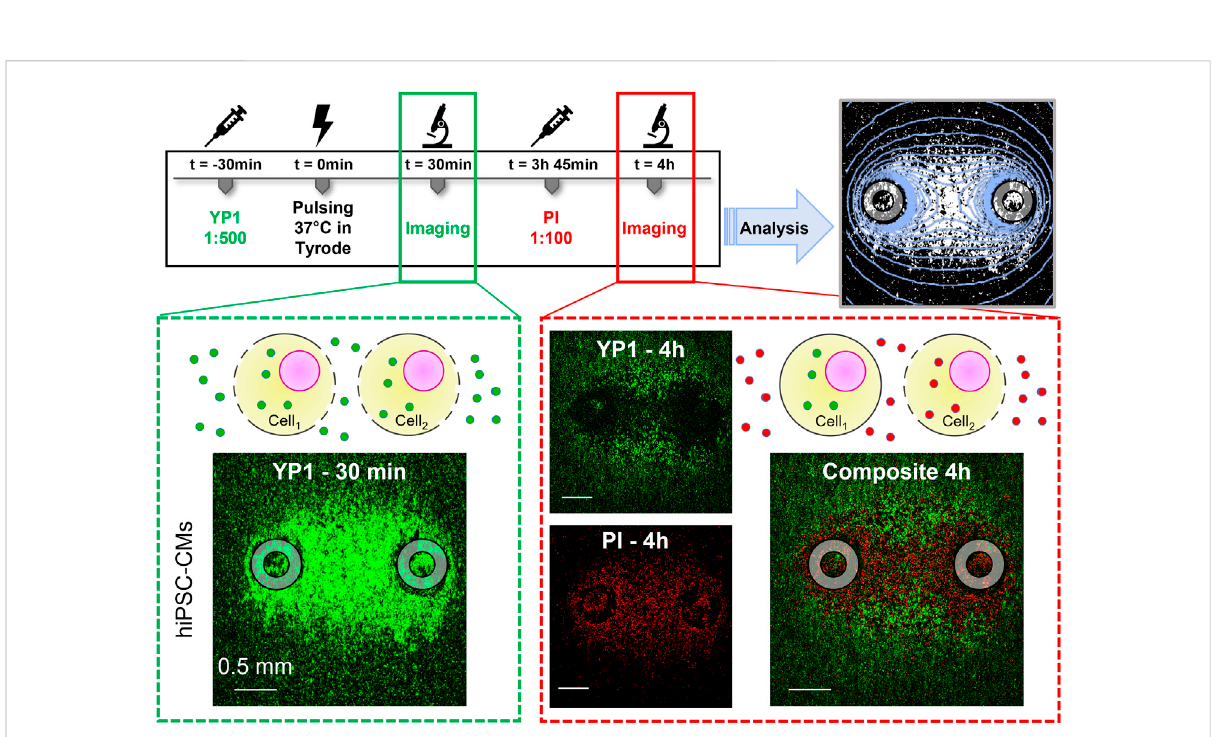
Human induced pluripotent stem cell-derived cardiomyocyte (HiPSC-CM) staining, electroporation, imaging, and analysis timeline. YP1 was added to the modi fi ed Tyrode solution 30 min prior to PFE treatments. YP1 images were acquired 30 min after PFE treatment to evaluate the full extent of cell electroporation. Immediately after imaging, cells were moved to a 37 ° C 5% CO 2 incubator in iCM-SF. During this time, the plasma membrane of cells reversibly electroporated resealed. Fifteen minutes prior the 4 h imaging, iCM-SF was substituted by modi fi ed Tyrode solution containing PIstainingpermanentlydamaged cellmembranes.Overlayofgreen andred channels showed aPI-stained areasurroundingthe electrodes and a peripheral outer YP1-stained area of the electroporated cells. The transition between these regions was gradual, with a resulting region where cells stained with YP1 and cells stained with PI were detected. Analysis was performed for YP1 and PI staining at the end of the experiments to compare the areas identi fi ed by fl uorescence staining to the area identi fi ed by electric fi eld isolines (light blue). Gray circles indicate the footprints of the electrodes positioned orthogonally to the cell